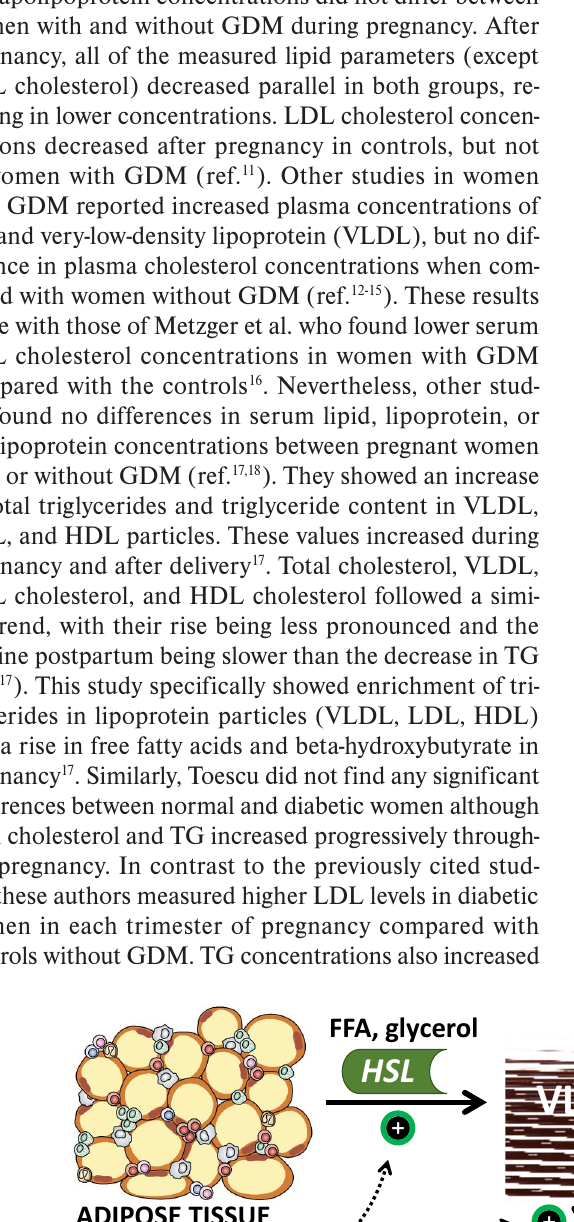
Table 1. Changes in lipid particles during pregnancy in GDM (ref. 19 ).